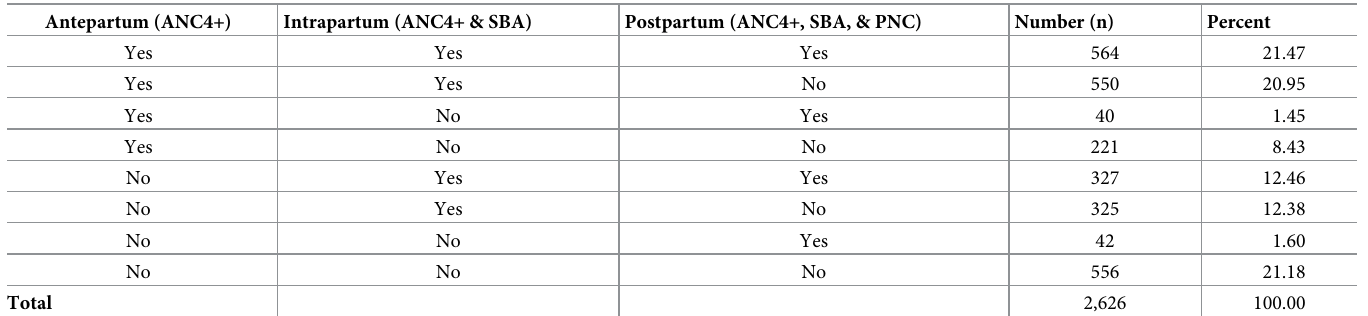
Table 2. Achievement of the continuum of maternal and newborn health care in Ethiopia,